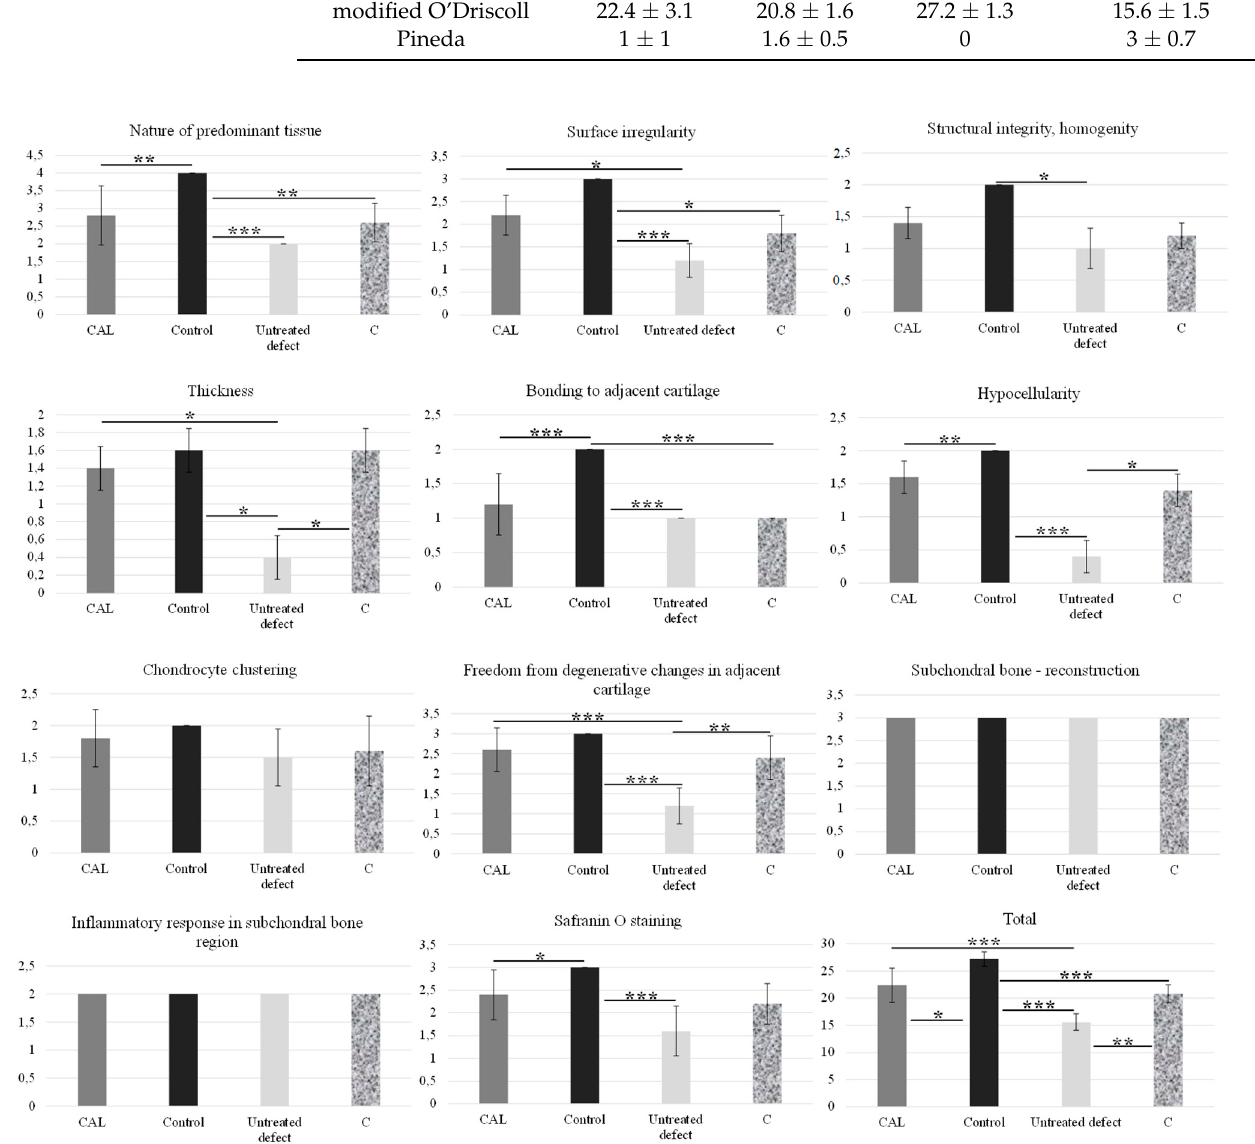
Figure 6. Results of modified O´Driscoll histological score. The total point means of the histological scores as well as most of the histological categories were significantly better in the treated group compared to the untreated group. Data are Mean ± SD. Average values within columns are statistically significant at the level of * = p < 0.05, ** = p < 0.01, *** = p < 0.001.